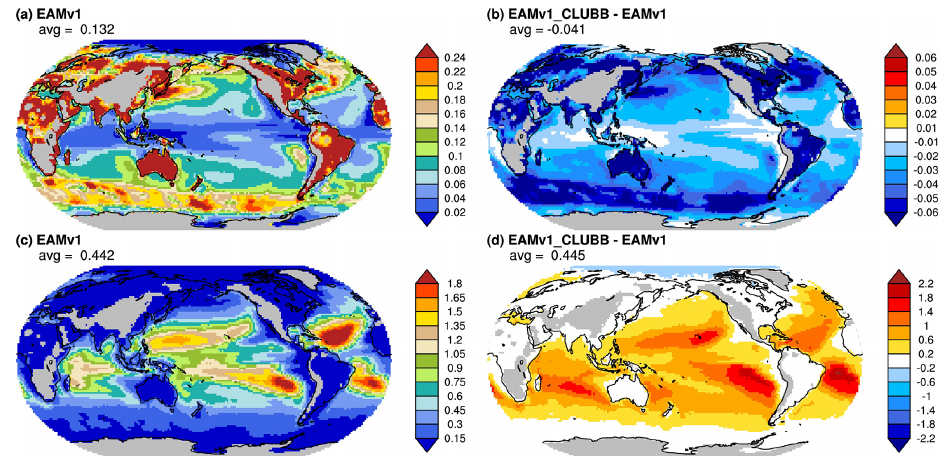
23 / 2 ) ) in EAMv1. (d)